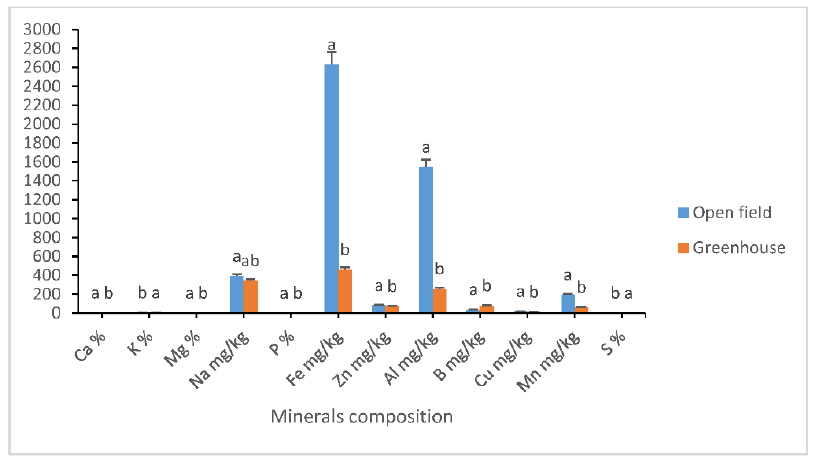
Figure 6. A comparative diagram showing the differences in mineral composition of A. Cruentus L. under open field (blue) versus greenhouse (orange) conditions, a referrer to open field whilst b referrers to greenhouse